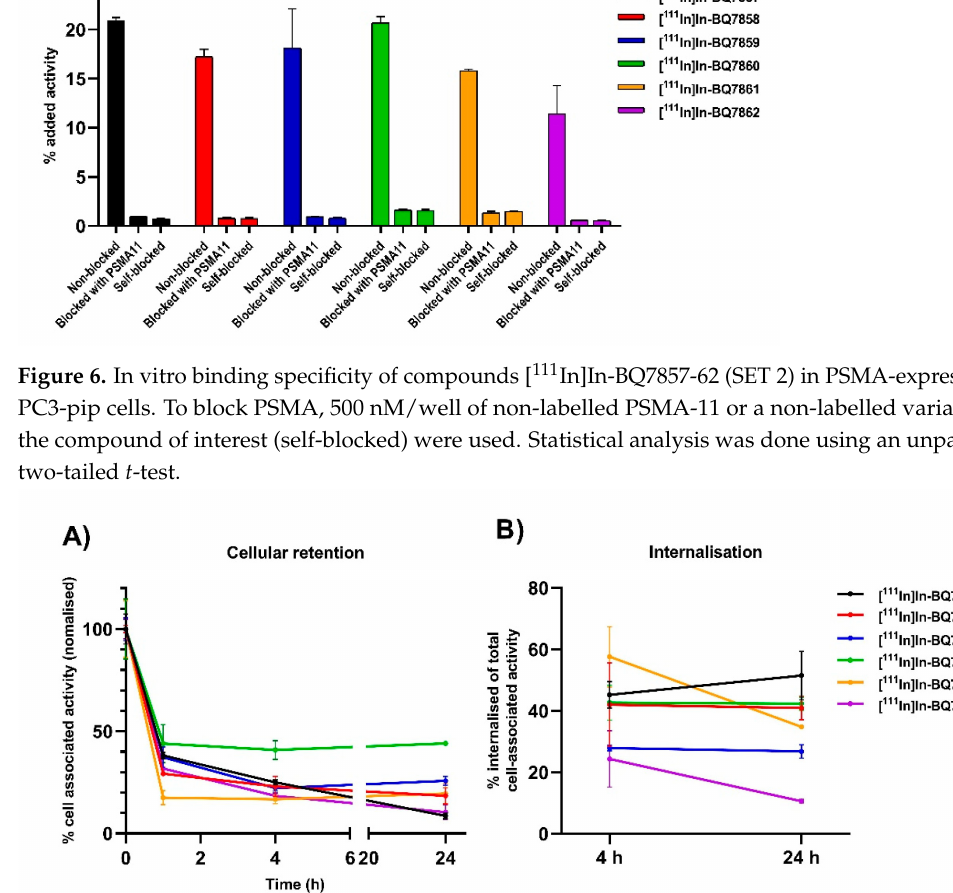
Figure 7. Cellular retention study using PSMA-expressing PC3-pip cells of [ 111 In]In-BQ7857-62. ( A ) Total cell-associated activity at 1, 4, and 24 h. ( B ) Percentage of internalised activity based on the total cell-associated activity at 4 and 24 h time-points. Statistical analysis was done using a one-way ANOVA with the Bonferroni’s test, corrected for multiple